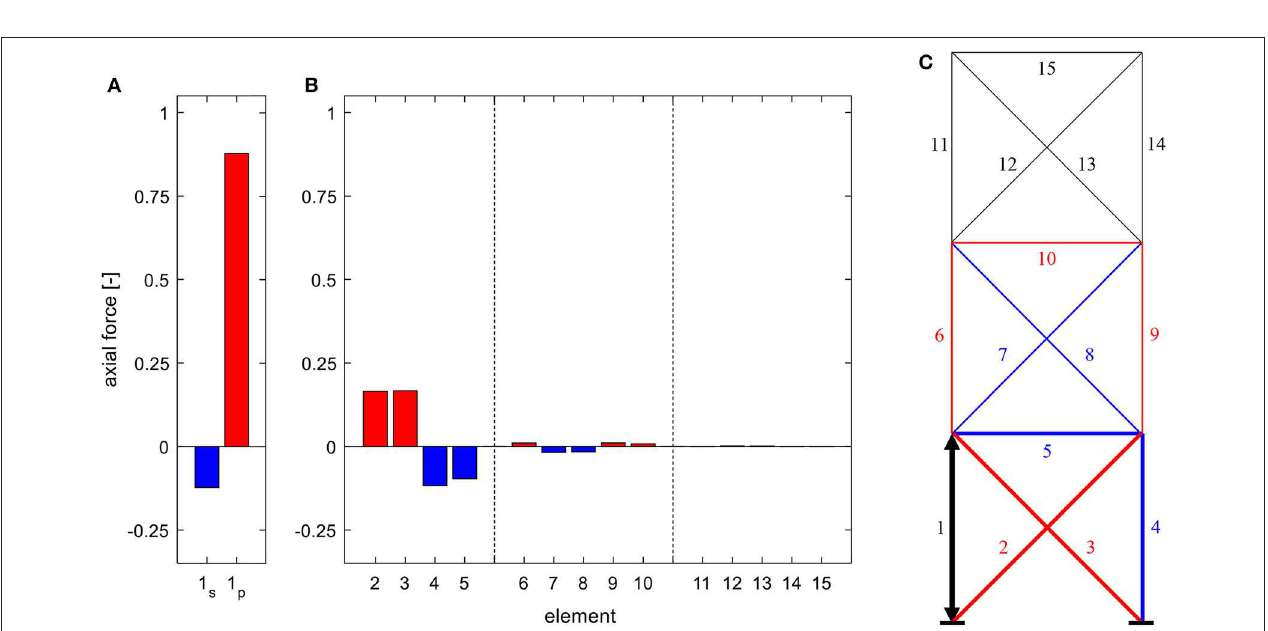
FIGURE 6 | Axial forces in (A) the actuated element for serial (index s ) and parallel (index p ) linear actuation, (B) the remaining structure due to the actuation of element 1 (C) , for a truss of the static degree of indeterminacy of n s = 3.